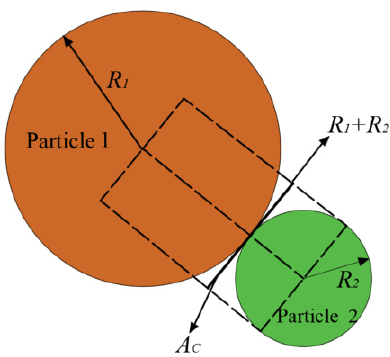
Figure 1. The linked bar model.